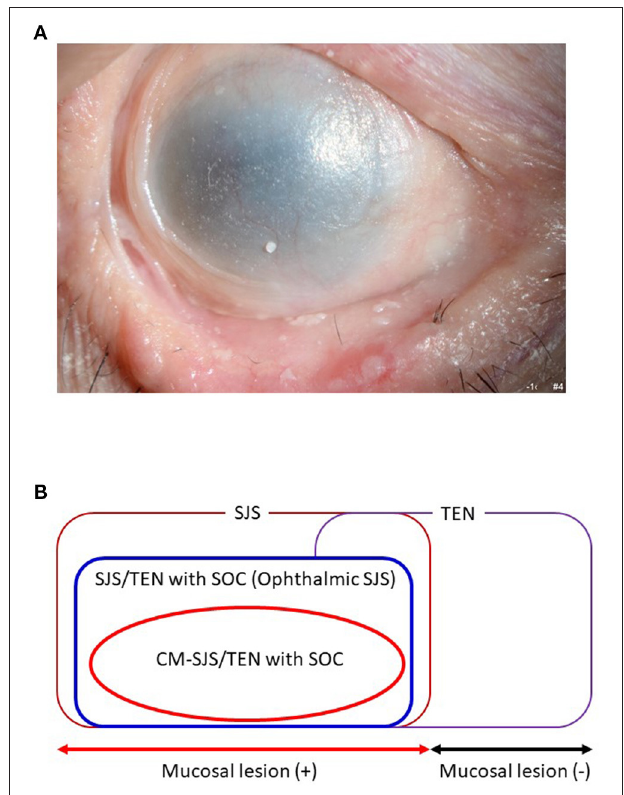
FIGURE 1 | (A) Ocular surface finding of SJS/TEN with SOC. (B) Ophthalmic SJS means SJS/TEN with